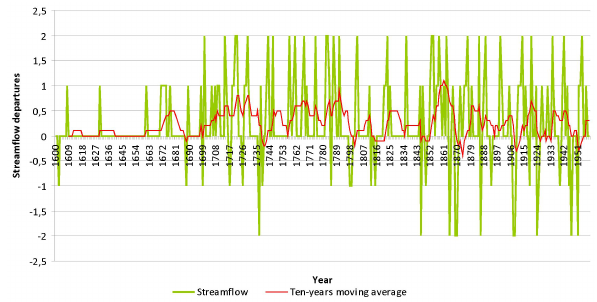
Fig. 3. Mendoza River Streamflow, 16th–20th centuries Categories: extraordinary streamflow=2; large streamflow=1; regular stream- flow=0; low streamflow= − 1; extremely low streamflow= − 2. 10- yr moving average (Prieto et al., 1999; Prieto and Garc´ıa Herrera, 2009; Neukom et al., 2009).